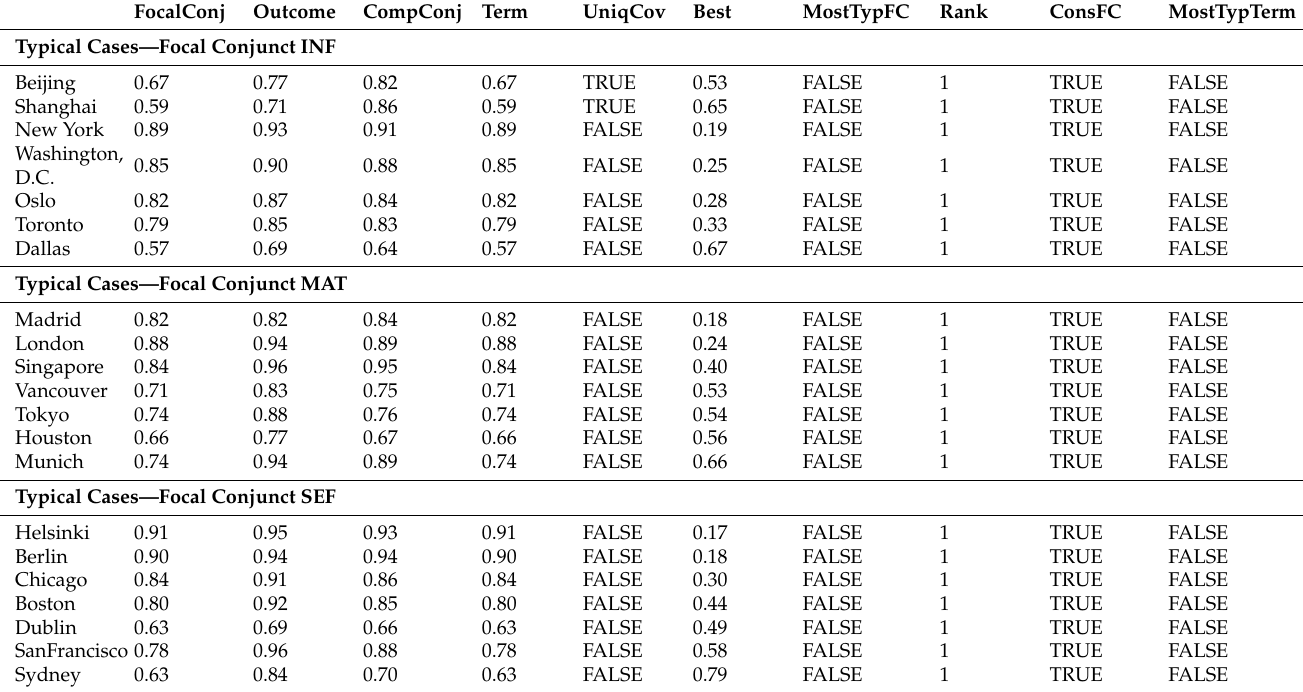
Table 4. Analysis of typical cases for